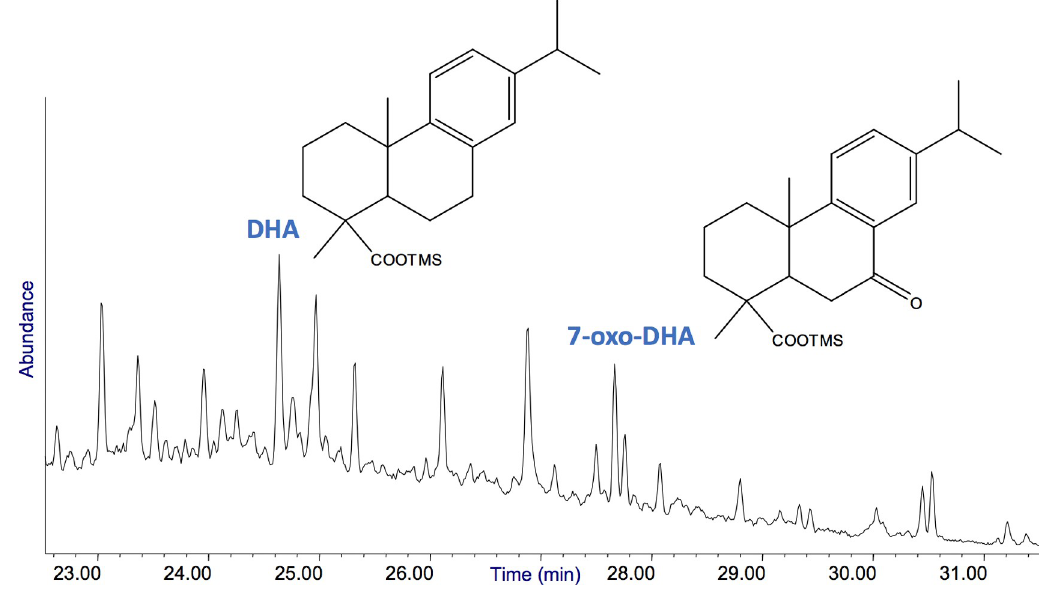
Fig 9. Inset of the GC/MS profile of sample AGO 10 (the Levallois flake) highlighting the peaks due to methyl- dehydroabietate (Me-DHA), dehydroabietic acid (DHA) and 7-oxo-dehydroabietic acid (7-oxo-DHA). The full chromatogram is presented in Fig K in S2